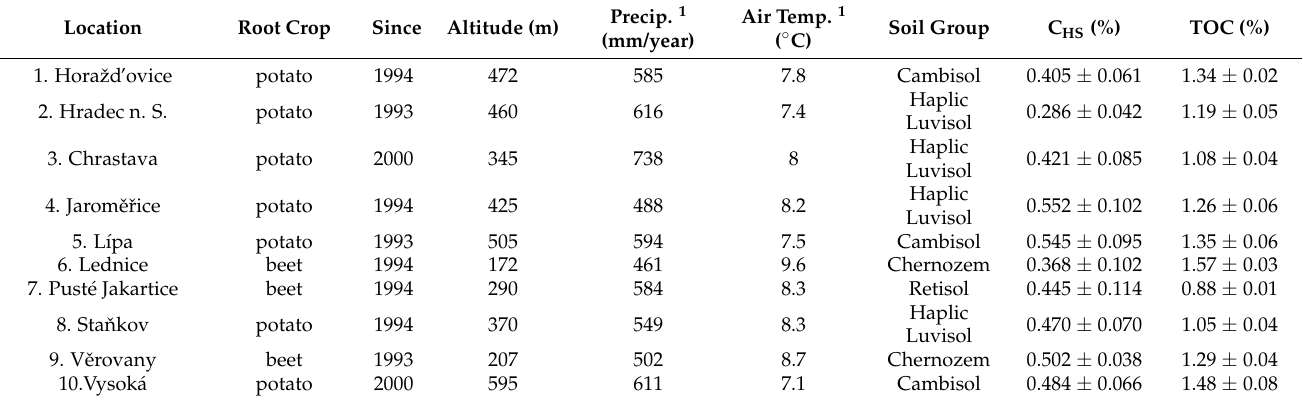
Table 1. Characteristics of the experimental sites and year of establishment of the experiment.